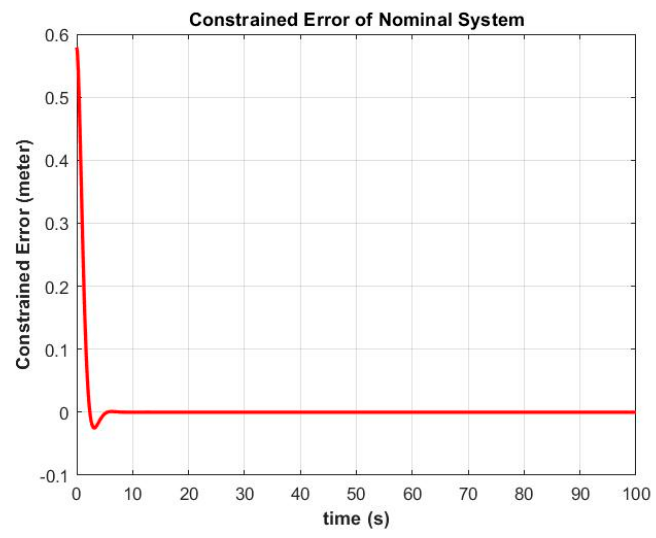
Figure 6. The error in satisfaction of the constraint equation ϕ 1 s = p d + q d sin ϕ tan θ + r d cos ϕ tan θ = 0.